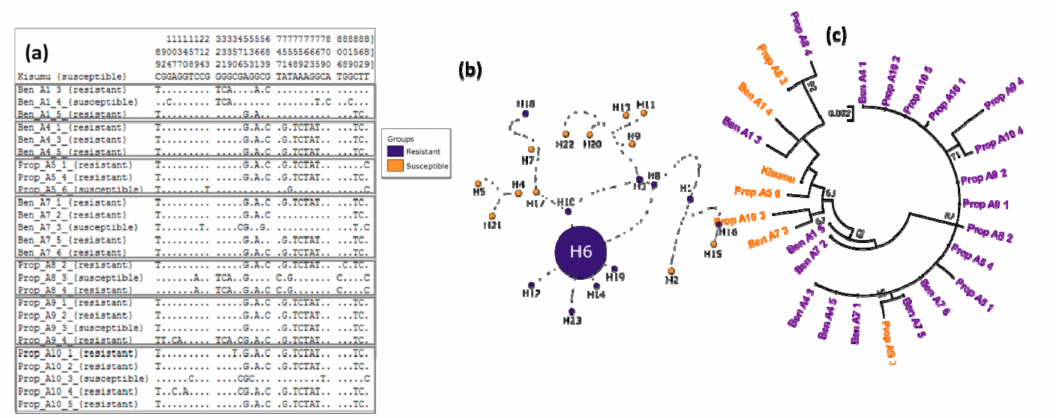
Figure 5. Polymorphism patterns of Ace-1 gene from cloning. ( a ) Polymorphic sites and haplotypes detected. ( b ) TCS haplotype network showing the resistant and susceptible haplotype clusters. Lines connecting haplotypes and each node represent a single mutation event. ( c ) Maximum-likelihood phylogenetic tree of Ace-1 gene supporting the clustering of haplotypes according to mosquito resistance status.